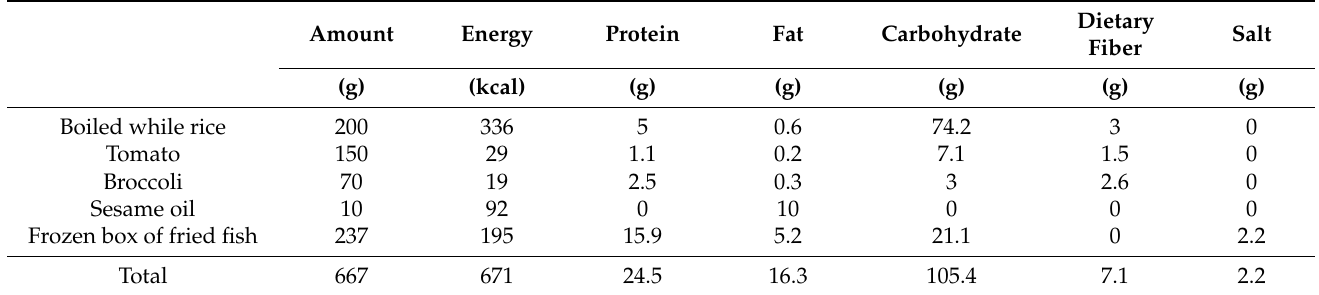
Table 1. Macronutrient contents of the test meal.